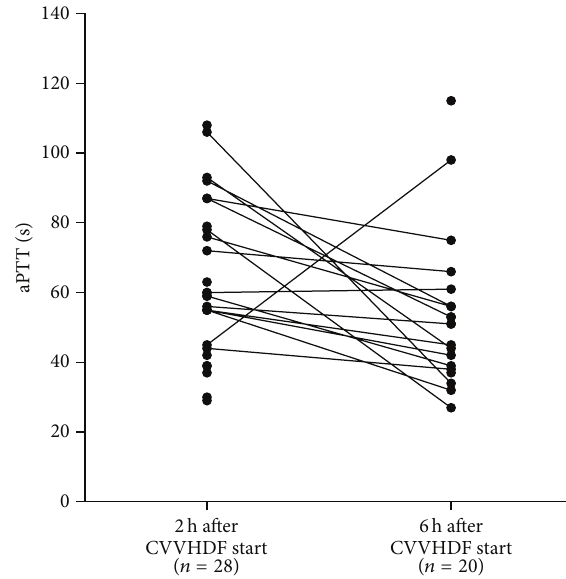
Figure 1: Postfilter aPTT values two and six hours after CVVHDF initiation.